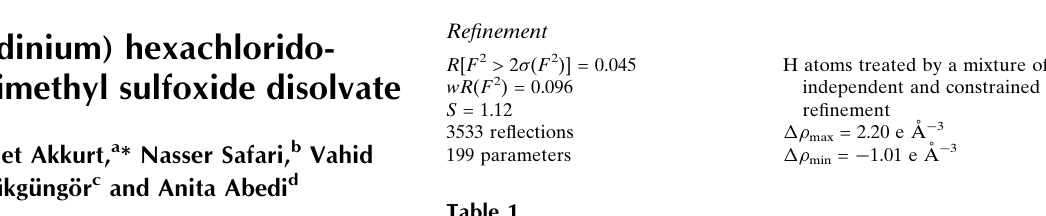
Hydrogen-bond geometry (A˚ , (cid:4)